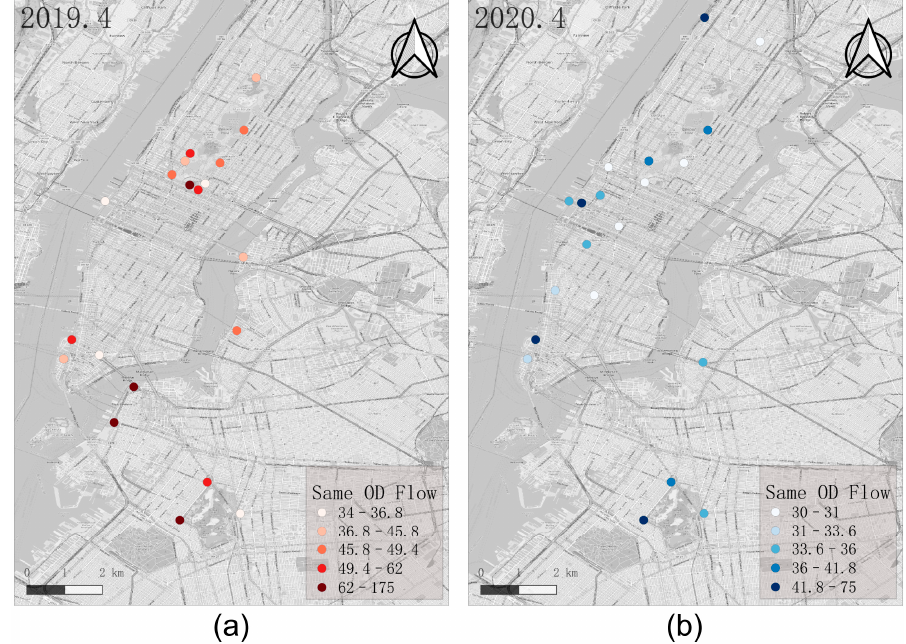
Figure 11. Twenty stations of largest flows with the same start and end stations ( a ) stations in 2019.4 ( b ) stations in